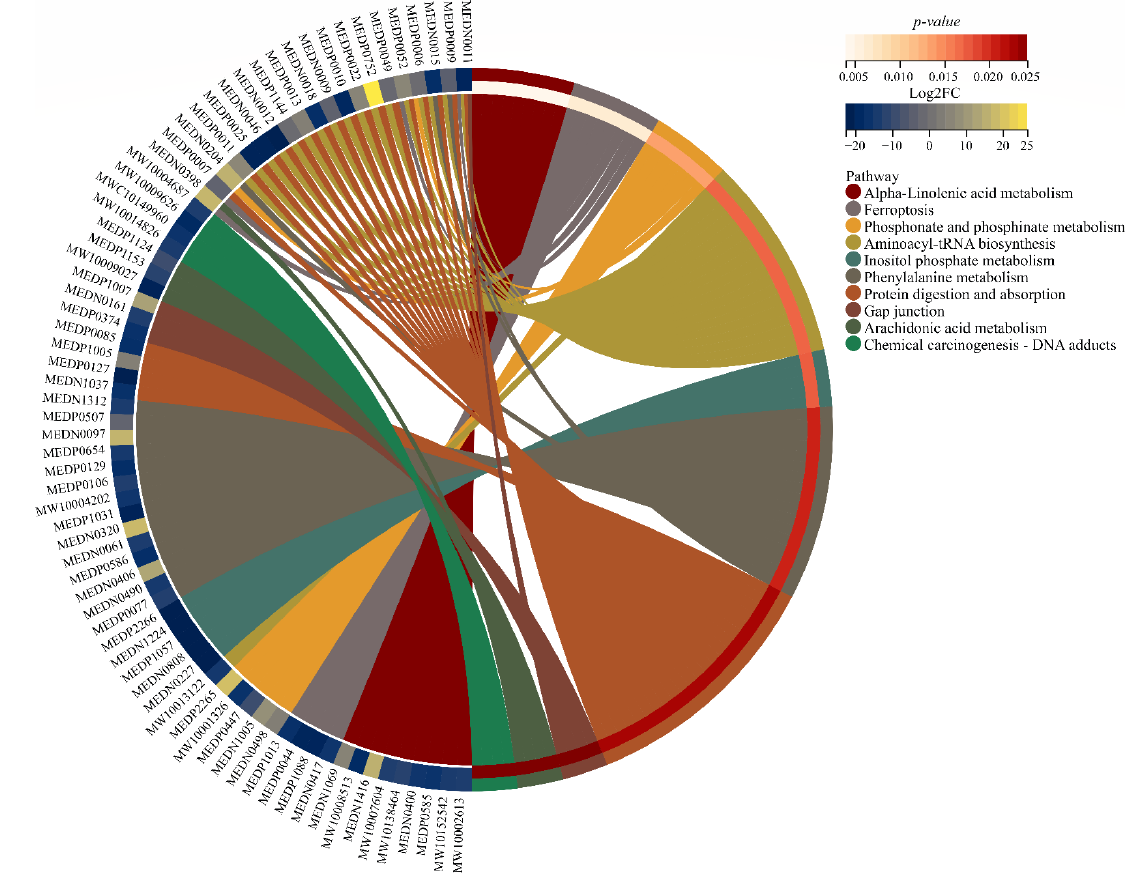
Figure 5. The circle plot of enriched KEGG pathways for DAMs in KF vs. dKF. The Log 2 FC of DEGs in the corresponding pathway was represented by color from blue to yellow (low to high), and the enrichment p -value of the corresponding pathway was represented by the colors from white to red (low to high). MEDxxx, MWxxx or MWCxxx are the IDs of identified metabolites in the database. The connecting lines represent metabolites (left semicircle) are enriched to the KEGG pathway (right semicircle).